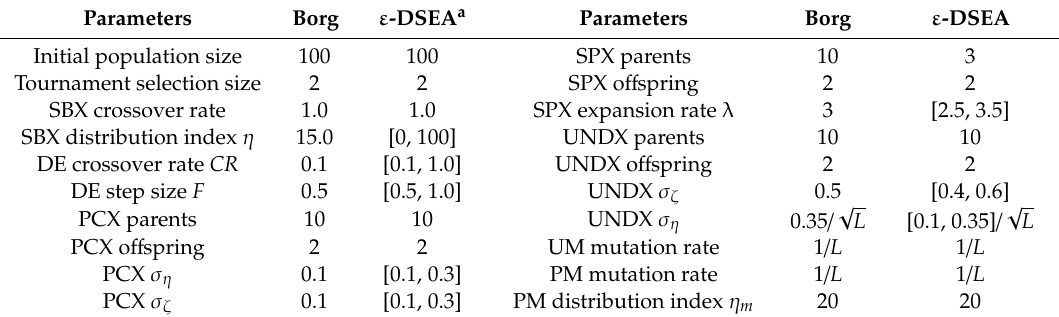
Table 2. Parameter values used in the optimization